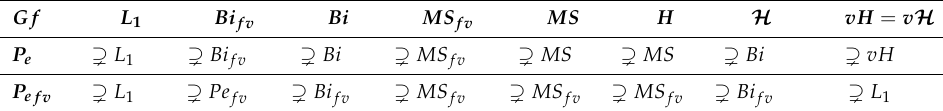
Table 5. Decomposition: Γ = G + f , scalarly def. G and gauge def.